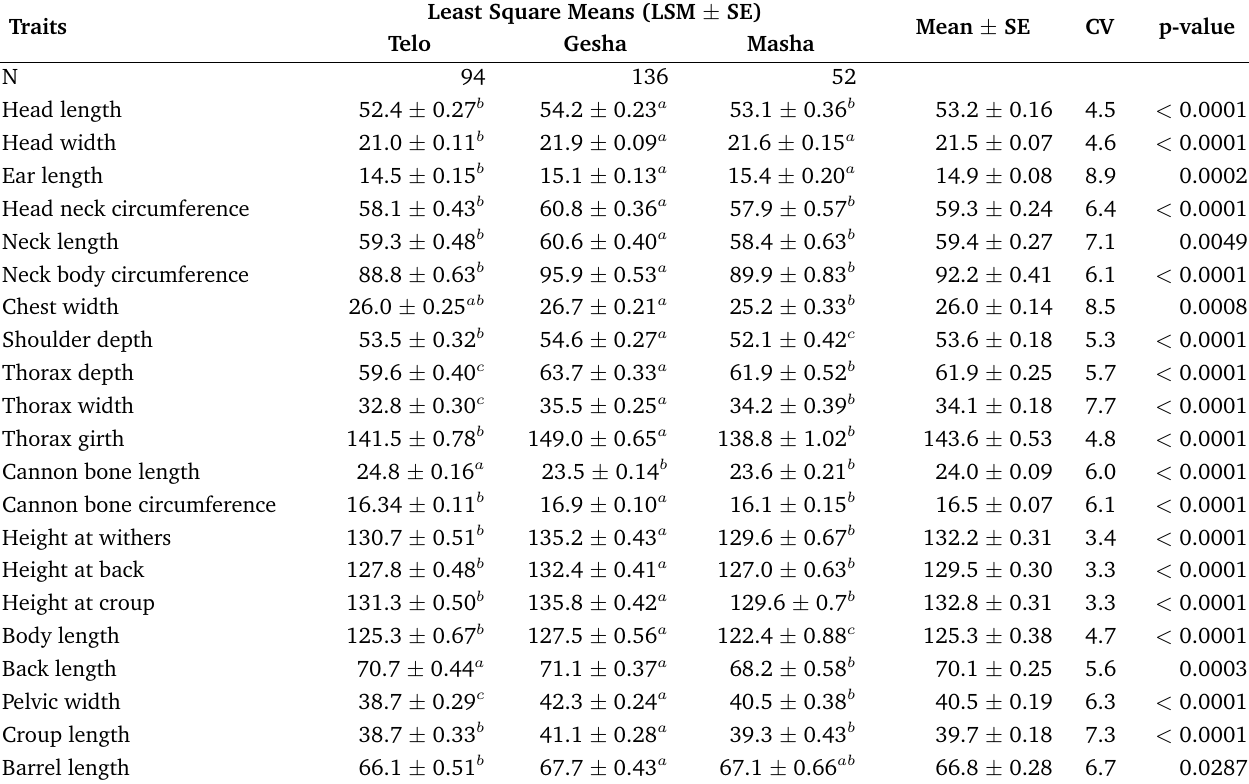
Table 4. Means and pairwise comparisons of morphometric measurements of the stallions from different locations. Means within a row bearing different superscripts are significantly different; a indicates the largest